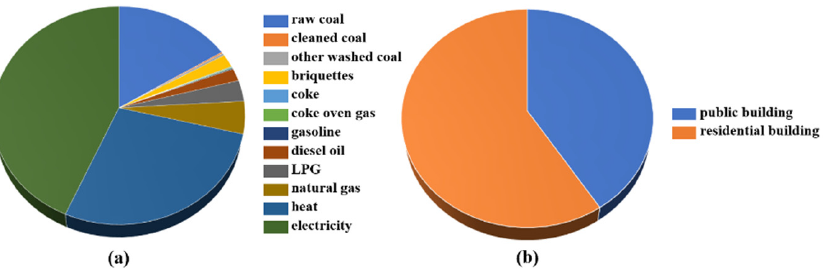
Figure 5. ( a ) Energy usage and resulting BECCE, and ( b ) BECCE from public buildings and residential buildings in China (unit: × 10 4 tons of CO 2 ).